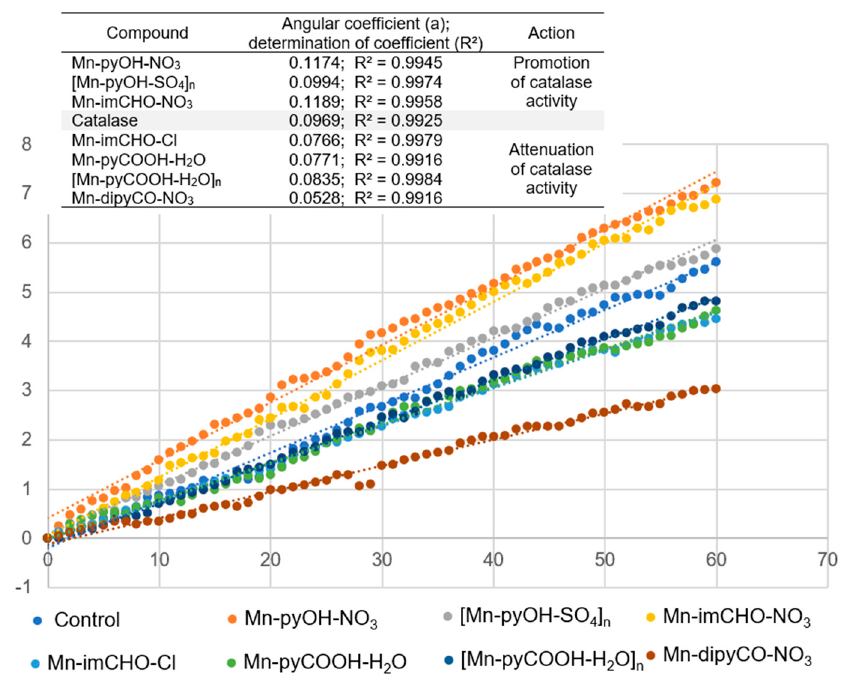
Figure 12. The effect of the Mn(II) complexes on the catalase activity.